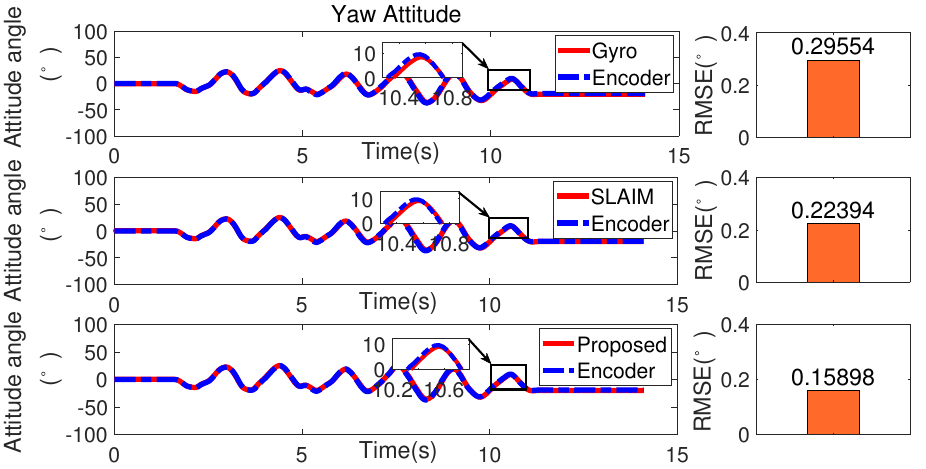
Figure 15. Yaw angular attitude comparison. The first subfigure is the attitude calculated by gyro, the second subfigure is the attitude processed by SLAIM, the third subfigure is the attitude processed by proposed